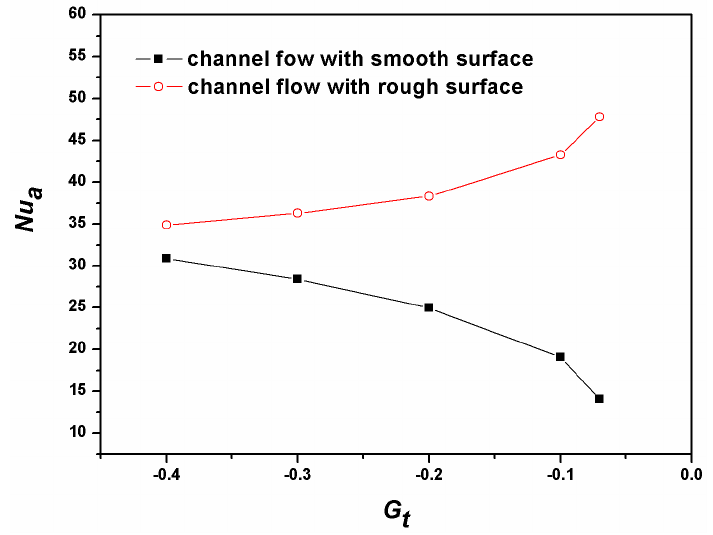
Figure 10. Averaged Nusselt number at the steady state for the channel flow with different surfaces ( 6.0  G